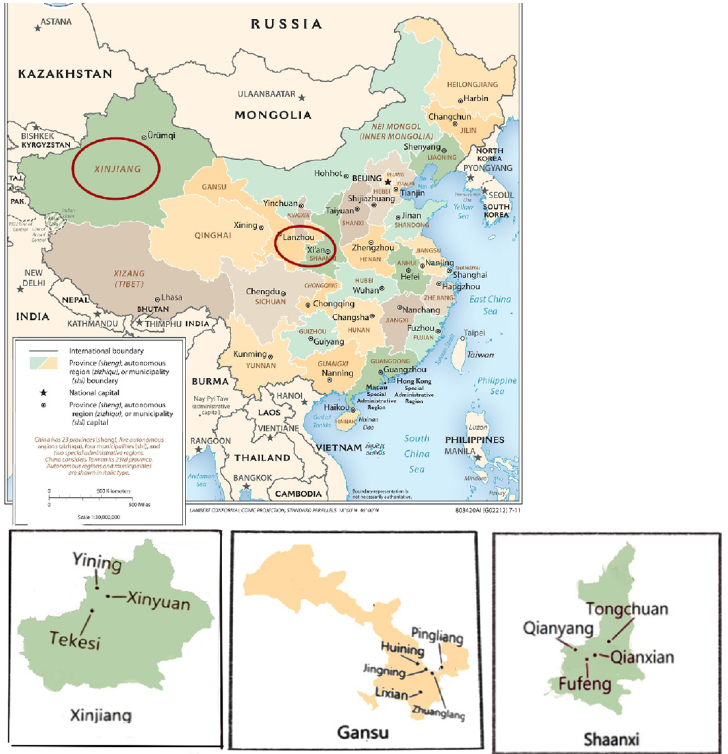
Fig 1. Three apple growing regions of Shaanxi, Gansu and Xinjiang in Mainland China and areas from where sample collection was carried out.